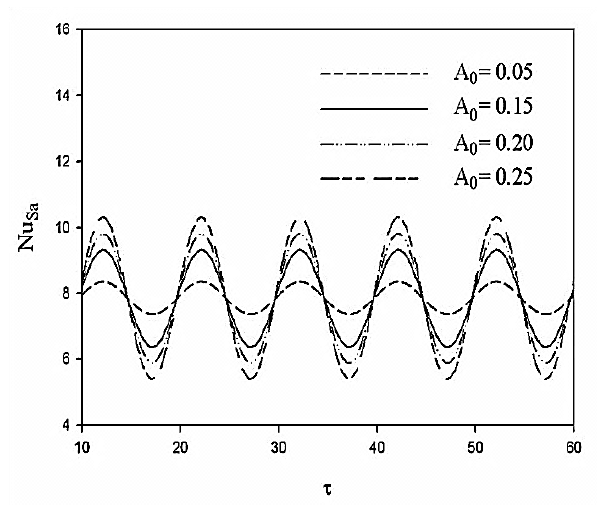
Fig. 5. Space-averaged Nusselt number for different amplitudes, A =0.05, 0.15, 0.20 and 0.25 at Re=100, 0 0.0 φ = and St=0.10.